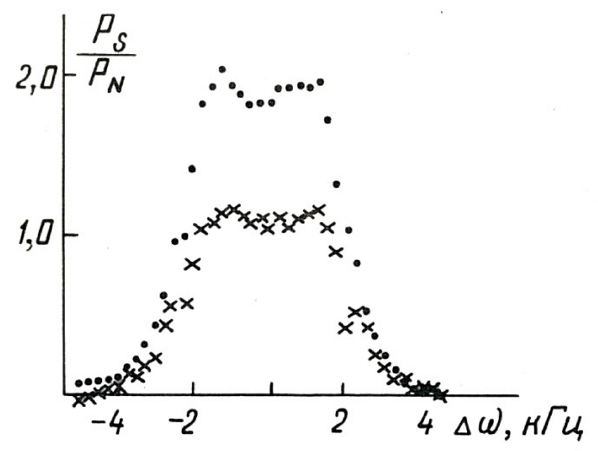
Figure 3. Ratio of incoherent scatter signal power to noise power for heights of 450km (dots) and 500km (crosses); the horizontal axis shows kHz. The graph of the first spectra is taken from the article published in Russian (Abramov et al.,